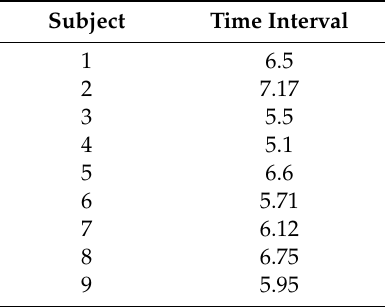
Table 2. Identified Optimum Intervals.